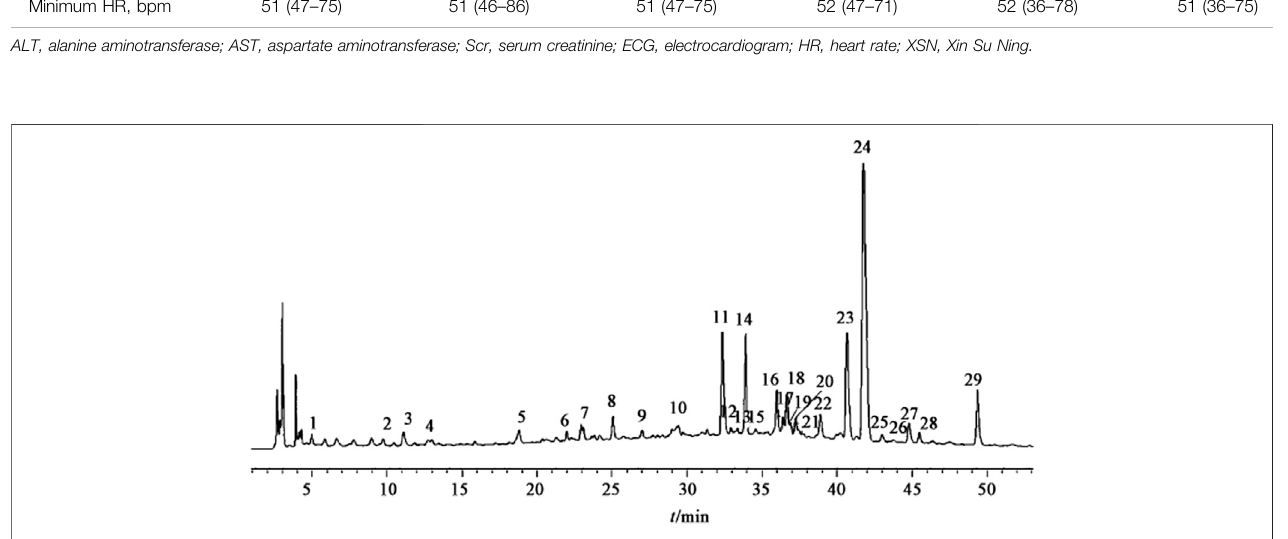
Frontiers in Pharmacology |